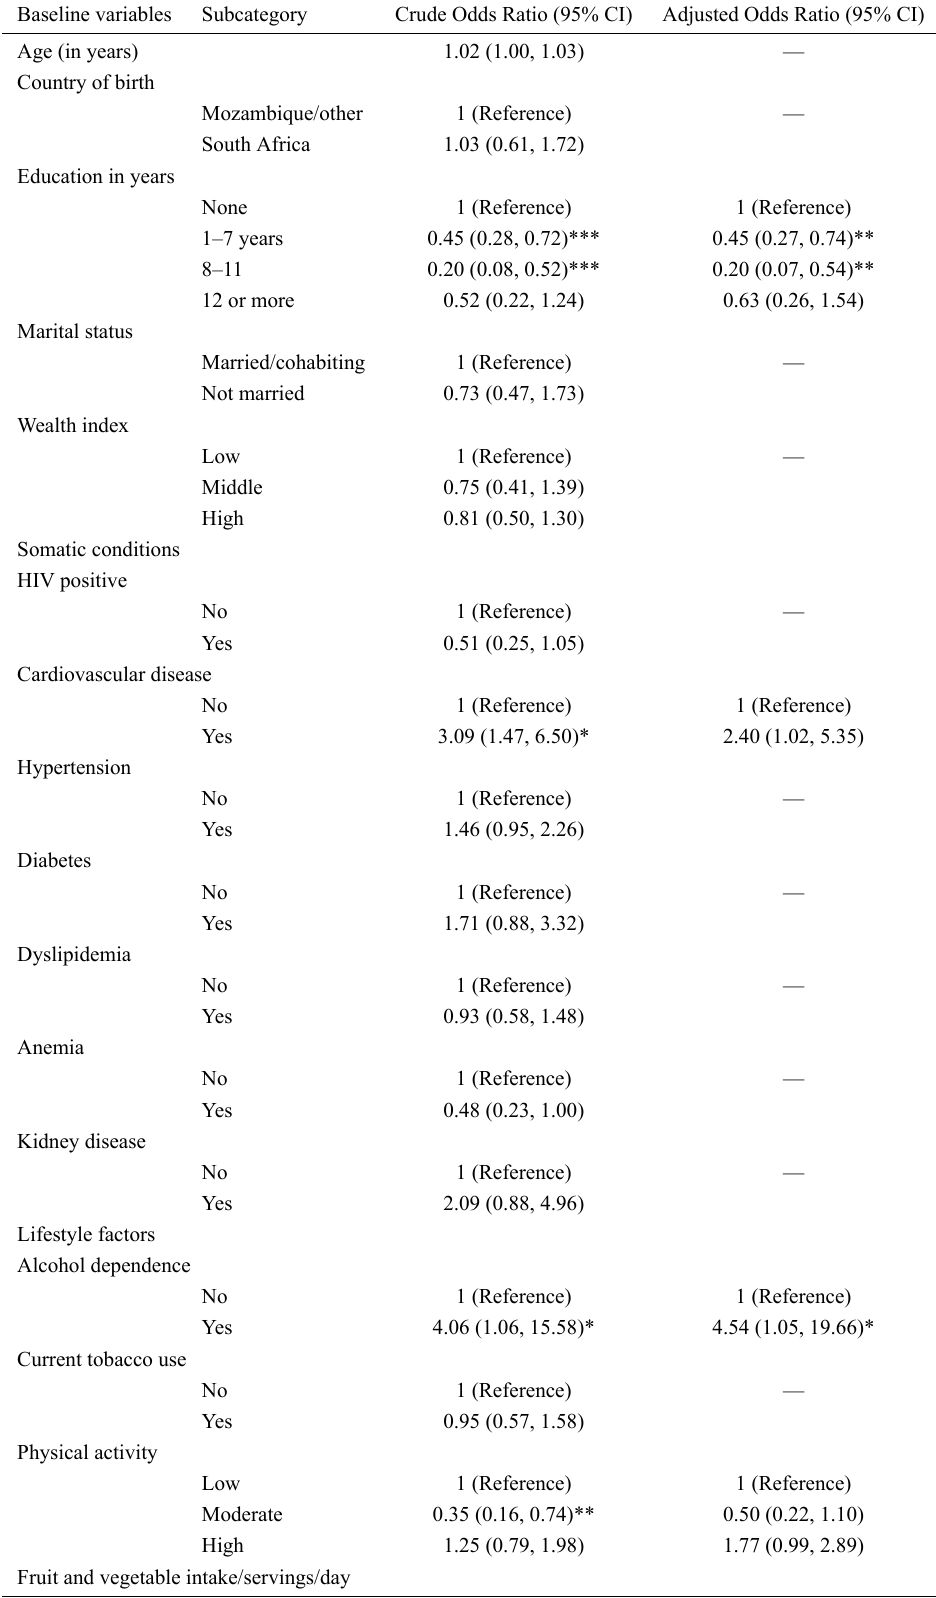
Table 3. Odds ratios for the association between chronic conditions, lifestyle factors and persistent depressive symptoms among men 40 years and older, HAALSI